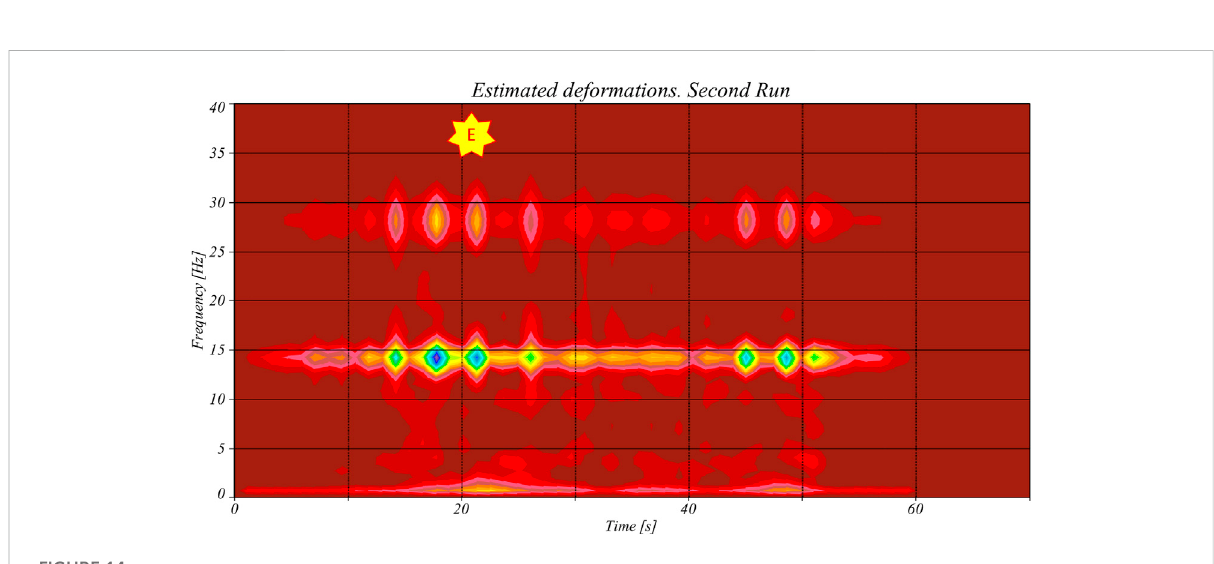
FIGURE 14 Spectrogram of the estimated deformations (Second